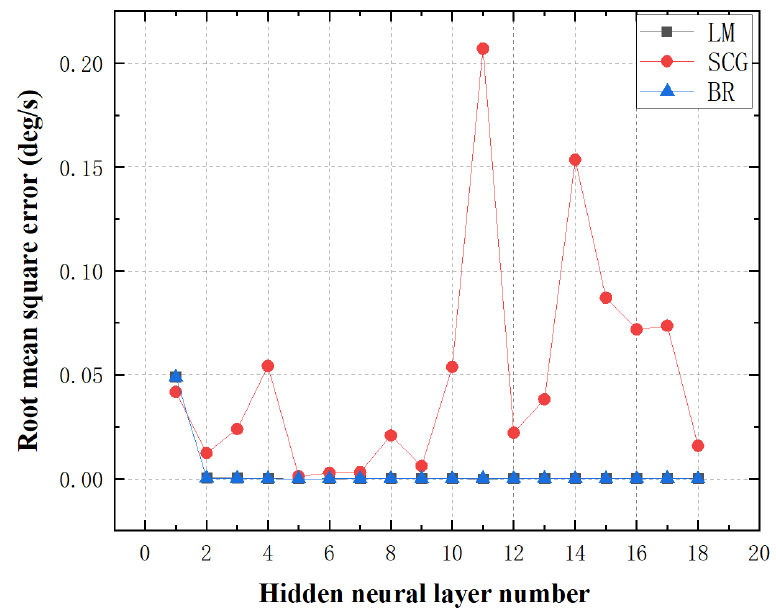
compared with the TDNP. pared with the TDNP.